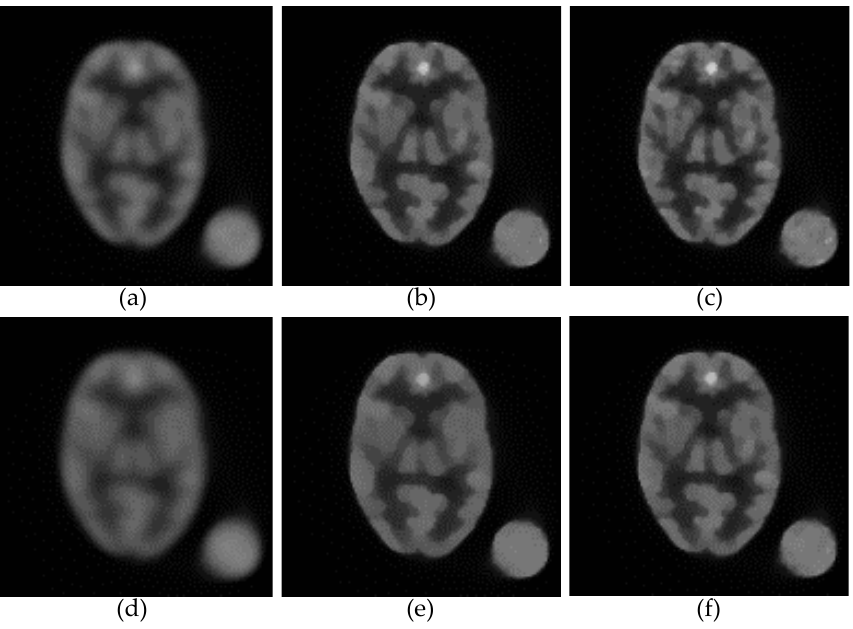
Figure 7. Anecdotal PL reconstructions: ( a ) LQR ( β = 10, PE = 40.02%); ( b ) NWMR ( β = 0.3, PE = 34.18%); ( c ) SDMR ( β = 0.3, PE = 33.17%); ( d ) LQR ( β = 25, PE = 43.95%); ( e ) NWMR ( β = 0.6, PE = 36.37%); ( f ) SDMR ( β = 0.6, PE = 34.47%).